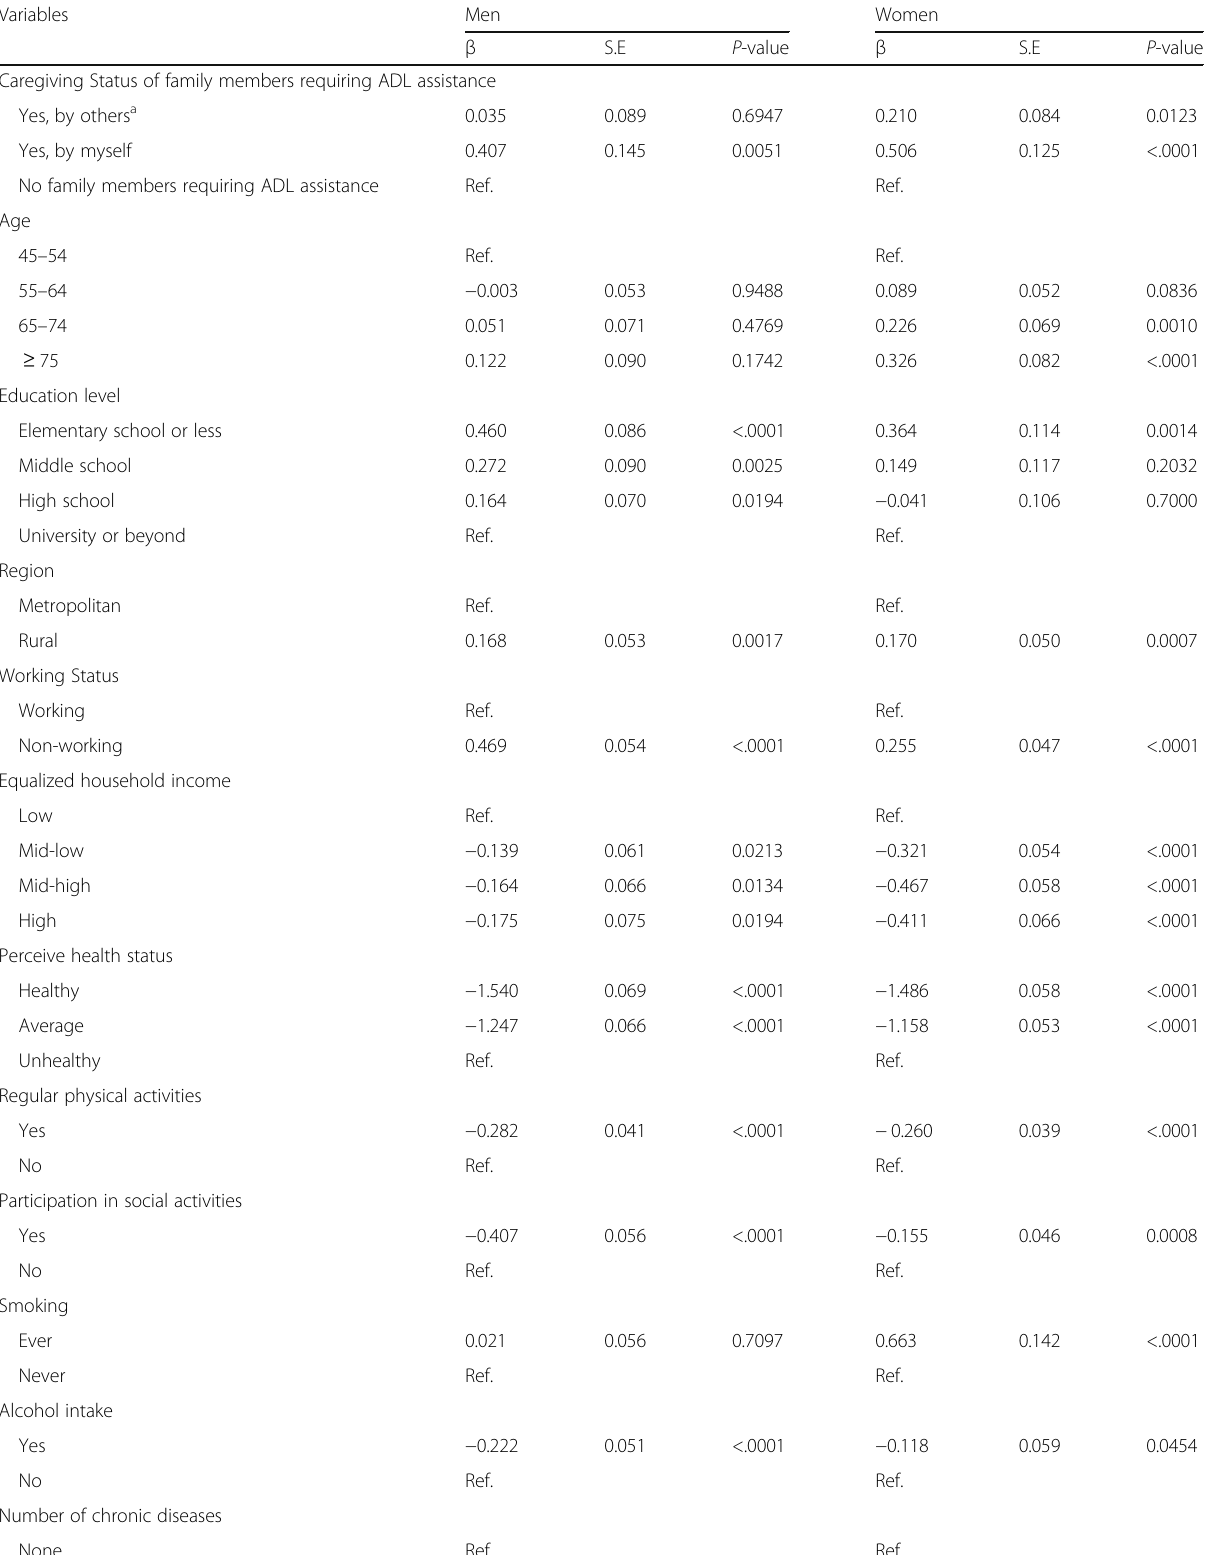
Table 2 Results of analysis of factors associated with CES-D 10